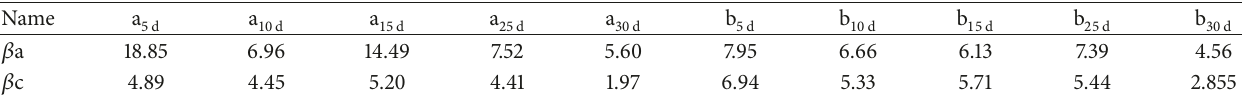
Table 2: Part parameters fitting magnetization curve of 2024-T31 aluminum magnesium